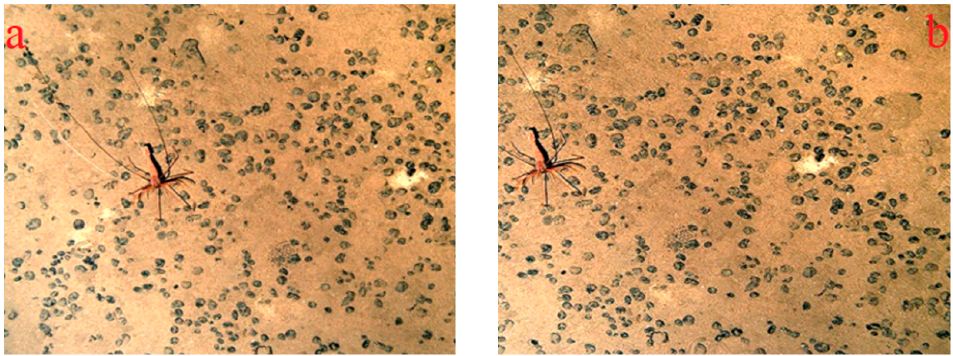
Figure 14. The improved images for T4: ( a ) Reference image; ( b ) Be-registered image. Table 5. Three image quality indexes of T3 and